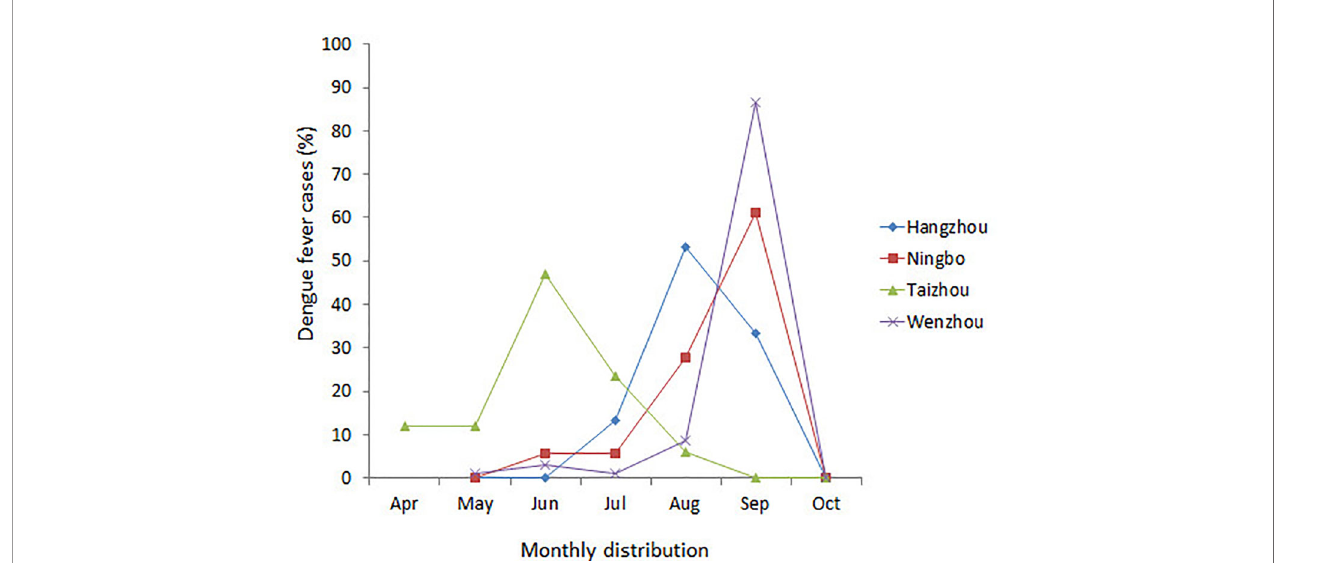
FIGURE 1 | Monthly distribution of dengue fever cases in four main cities in Zhejiang Province, China,